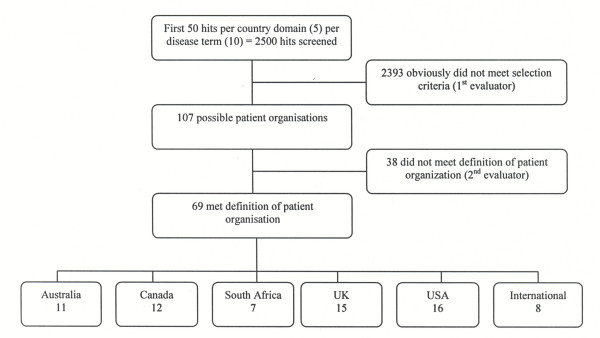
Flow diagram showing the selection process.